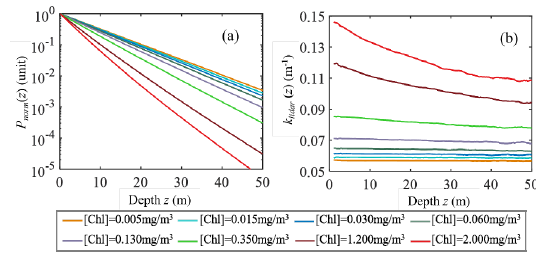
Figure 2. (a) Depth profiles of the normalized lidar return signals ( ) P z and (b) the corresponding effective norm attenuation coefficients ( ) k z for [Chl] between 0 to 2 lidar mg/m 3